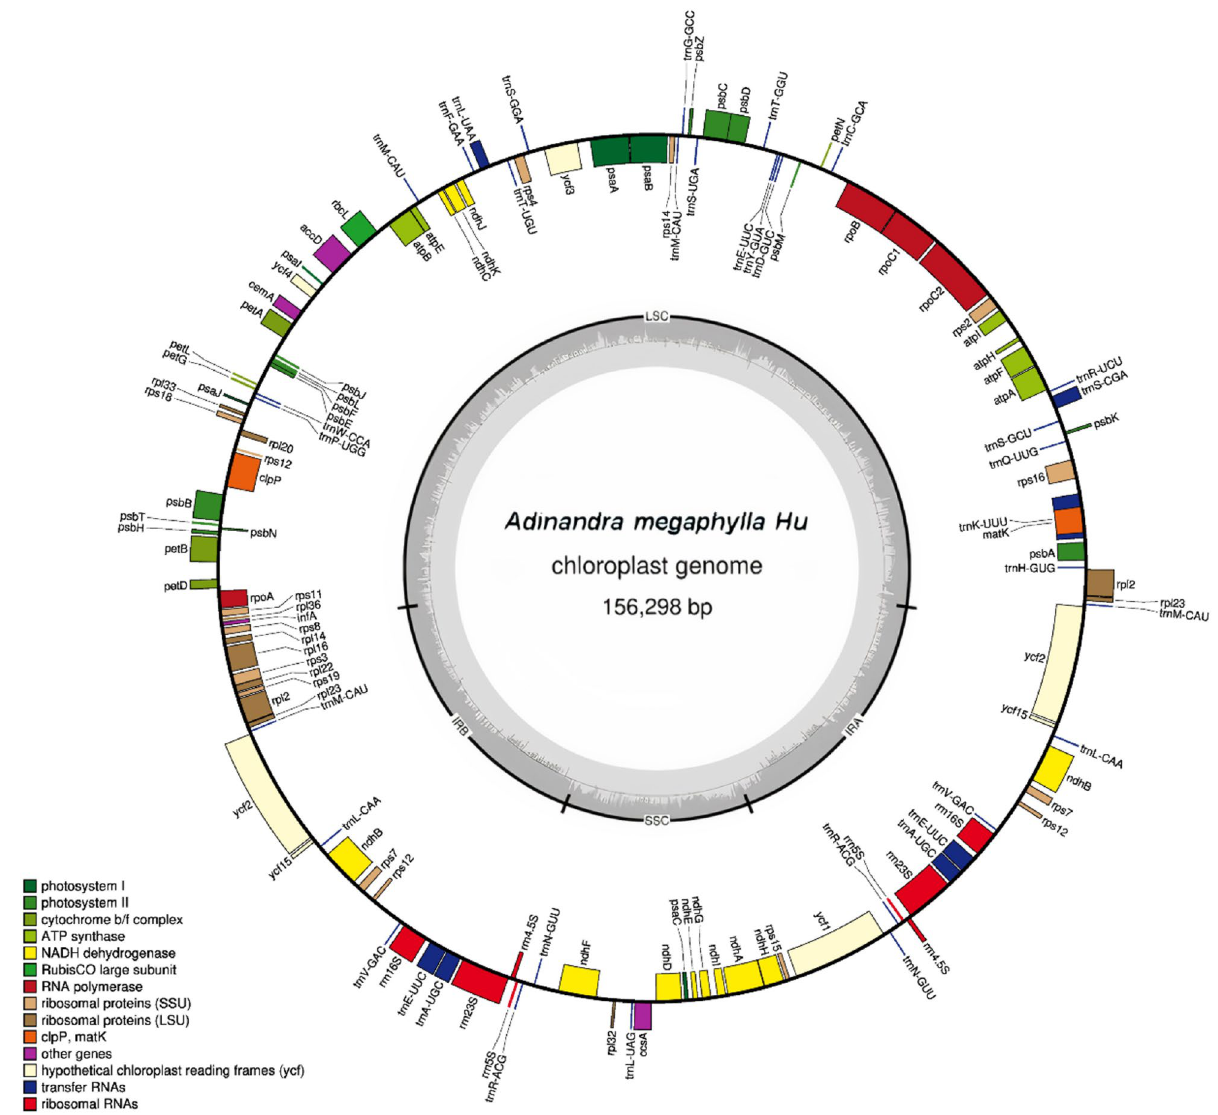
Figure 1. Chloroplast map of A. megaphylla Hu in Vietnam. Genes shown inside the circle are transcribed clockwise, whereas genes outside are transcribed counterclockwise. The light gray inner circle shows the AT content, the dark gray corresponds to the GC